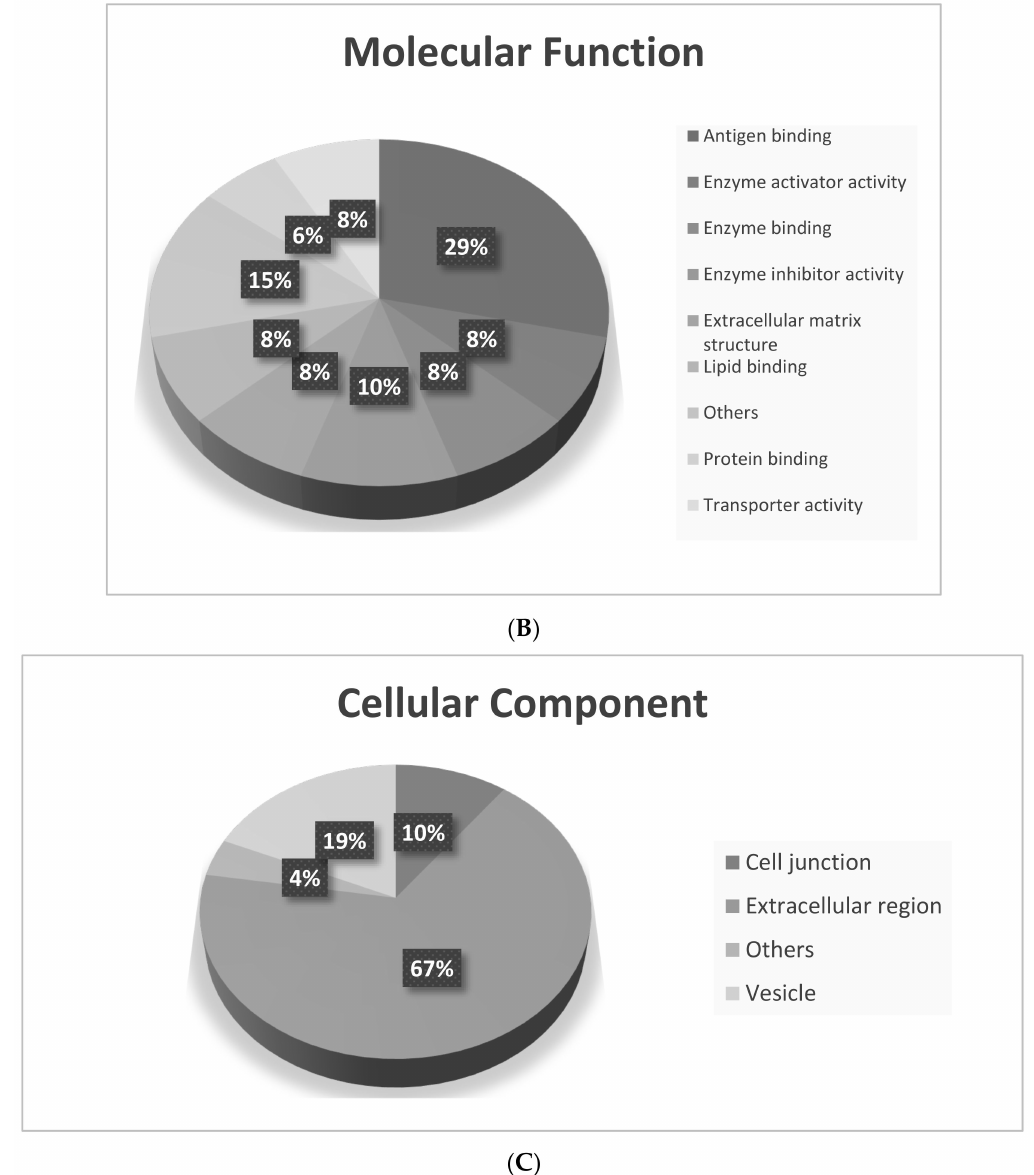
Figure 3. Gene ontology (GO) analysis of differentially expressed proteins of the aqueous humor (AH) in the cataract control, single-risk, and double-risk groups. We compared identified AH proteins from the three groups: ( A ) biological processes; ( B ) molecular functions; ( C ) cellular